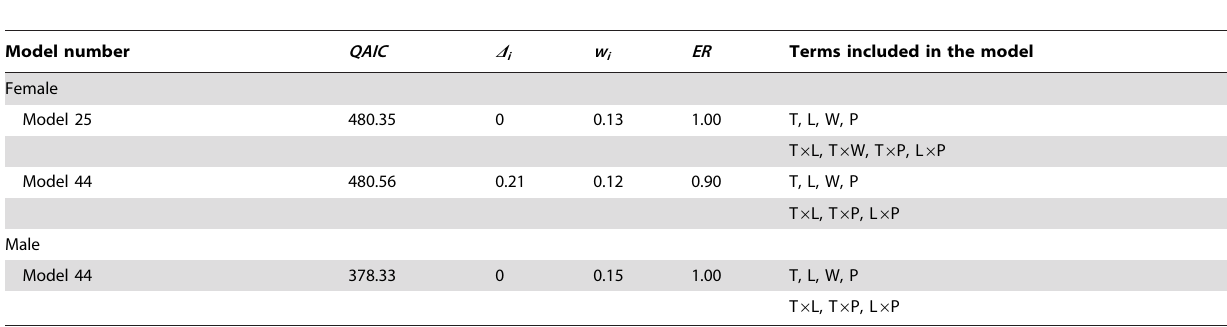
Table 1. Summary of statistics from model selection to identify the best sets of models that predicted flight of Pityophthorus juglandis in response to ambient temperature (T), light intensity (L), wind speed (W), and barometric pressure (P).